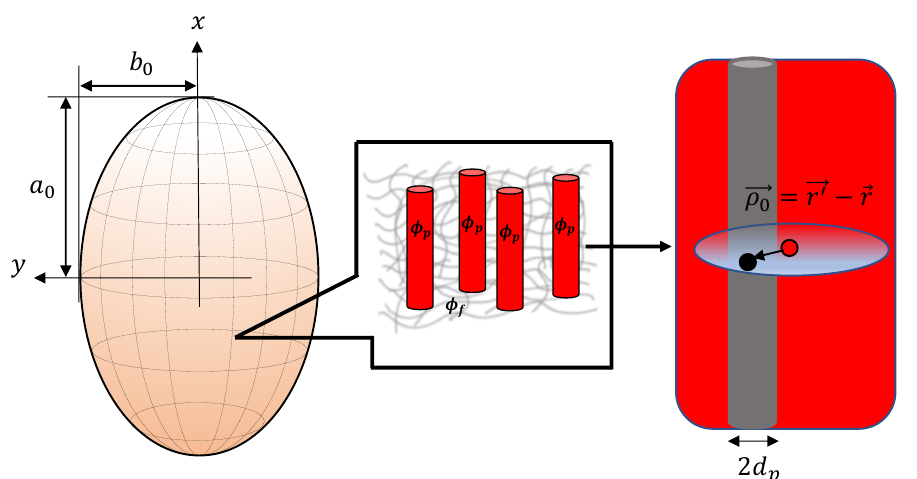
Figure 2. The image on the left represents schematics of an MAE sample with the shape of an ellipsoid of revolution having two equal semi-axes b 0 = c 0 and one distinct semi-axis a 0 . The magnified image on the right side depicts a smeared columnar